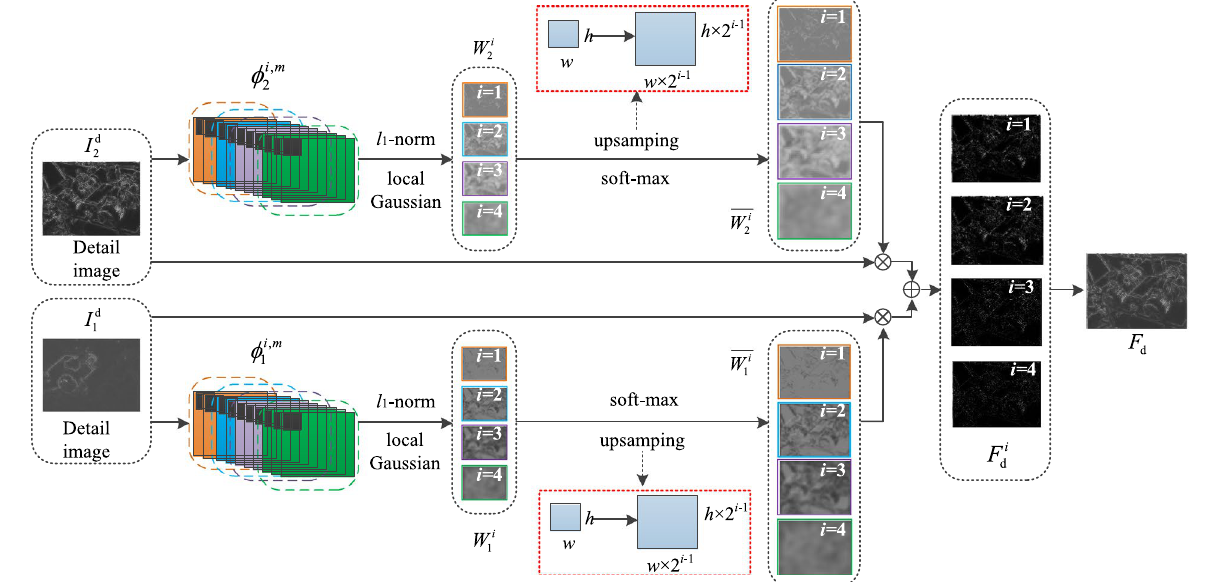
Figure 2. The fusion strategy framework of detailed